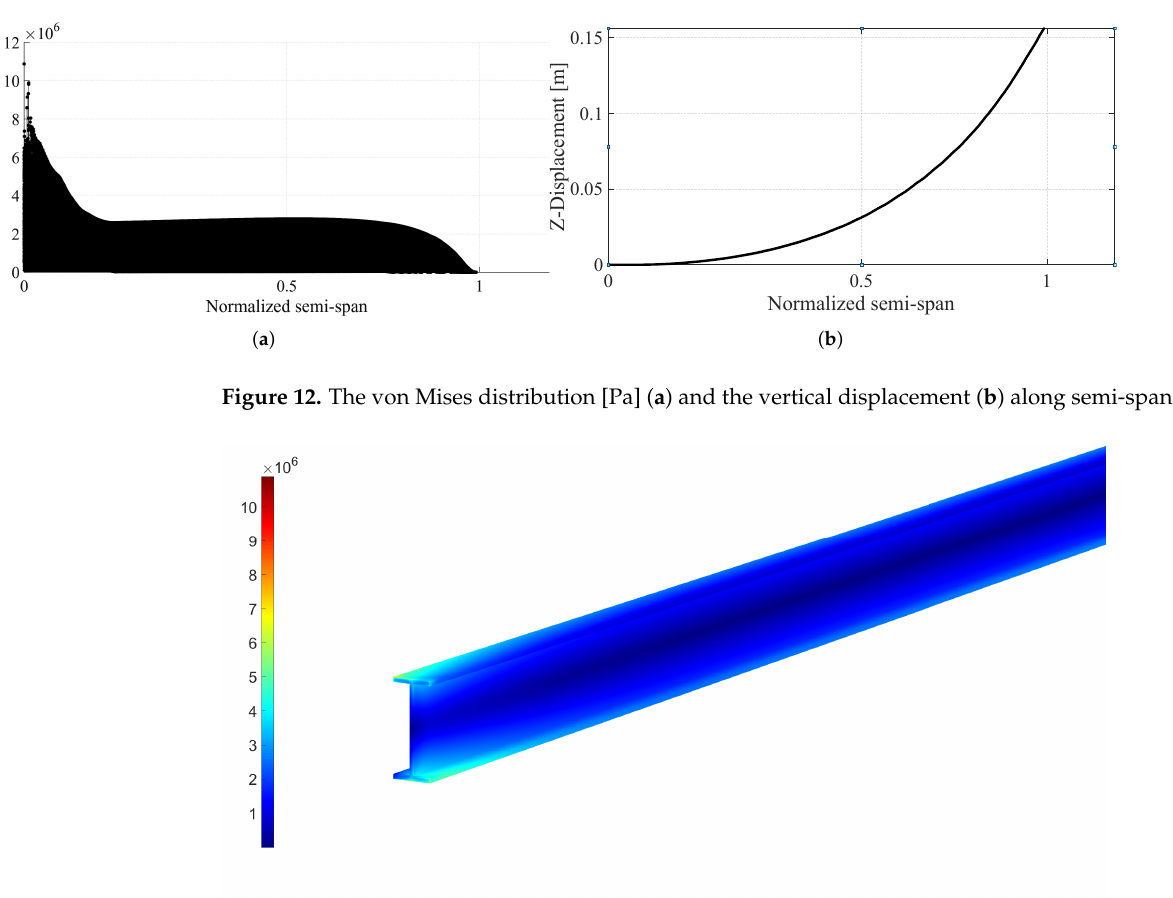
Figure 13. Von mises [Pa] distribution at the design